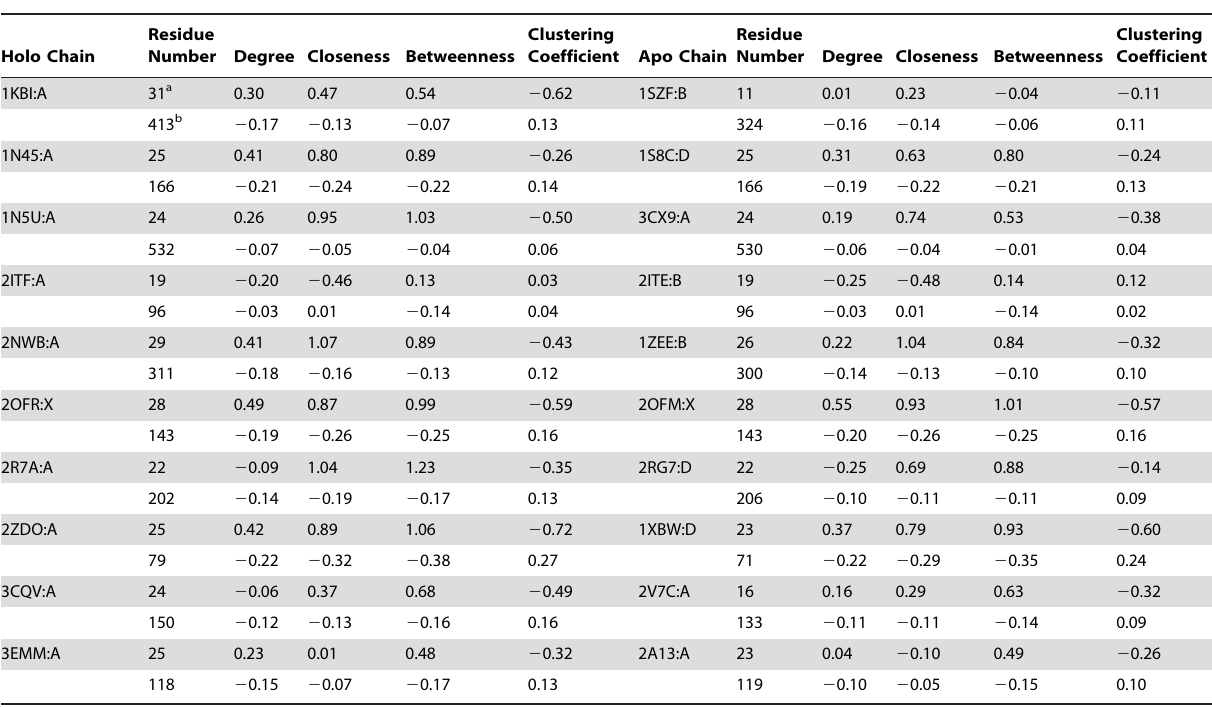
Table 5. Comparison of network-based features of holo-apo heme protein pairs.